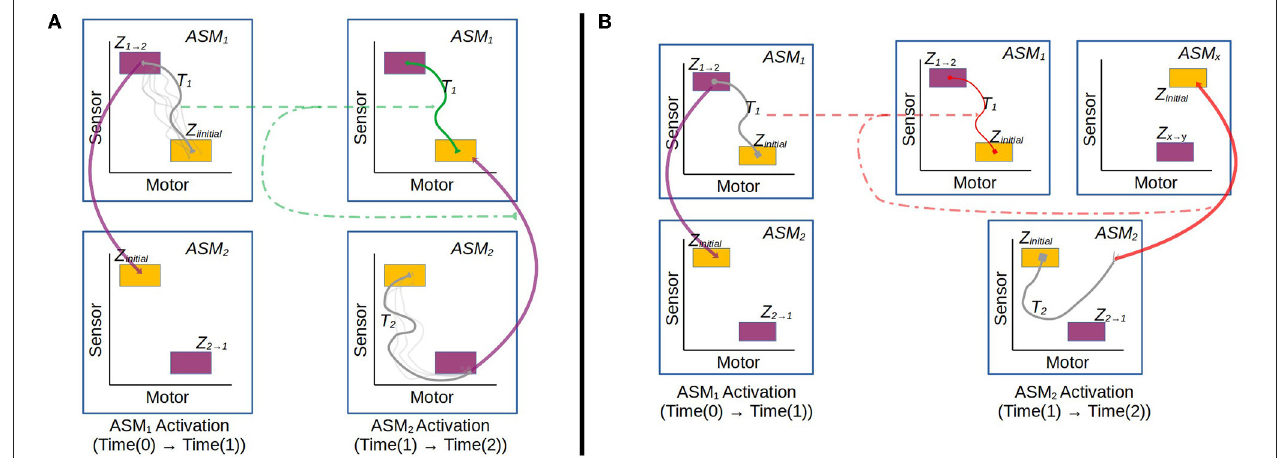
the end of Activation 2 the established conditions to transition to ASM 1 are not met, and activation passes to some other unit ASM x . This causes the trajectory from Activation 1 to be inhibited because it produced conditions which led to an unsuccessful